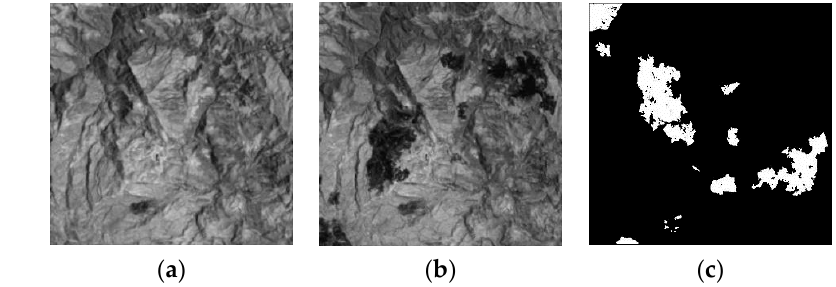
Figure 8. San Francisco dataset. ( a ) Image acquired in August 2003; ( b ) image acquired in May 2004; ( c ) ground truth.